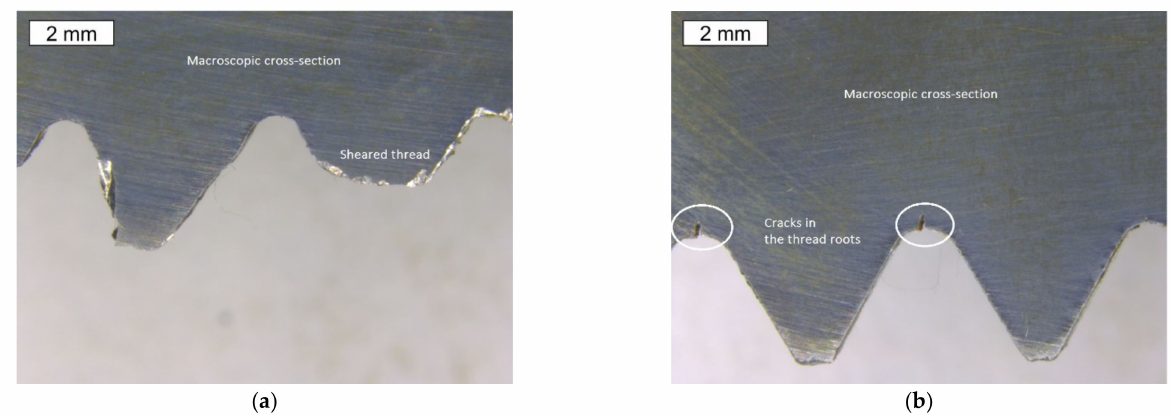
Figure 4. Stereoscopic image of the macro section, which was made at the longitudinal cross-section of the S1 bolt threadinside ( a ) and outside ( b ) of the macroscopic shear area. Visible cracks running along the thread